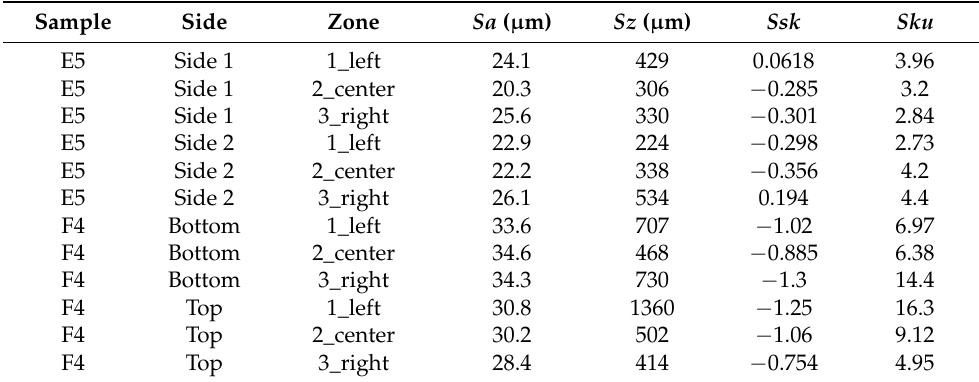
Table 5. Results of topography measurements according to ISO